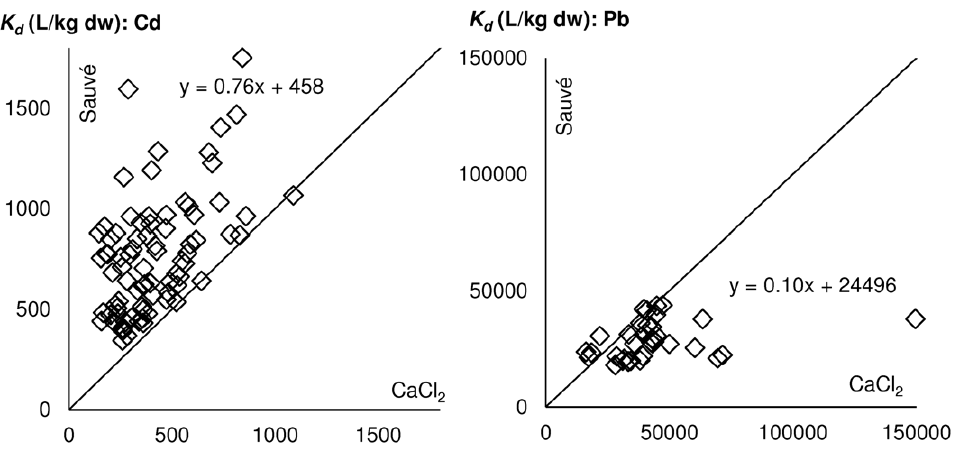
Figure 1. Estimated soil-water partition coefficient K d (Sauve´ regression) vs. measured K d (determined from CaCl 2 extractions). The dotted line indicates a ratio of one. doi:10.1371/journal.pone.0047002.g001 wheat GWS 2000 (lower) and wheat BIOW 2006 (lower) was the measured concentration of Cd in leaf and stem significantly (p , 0.05) different for treatment and control.